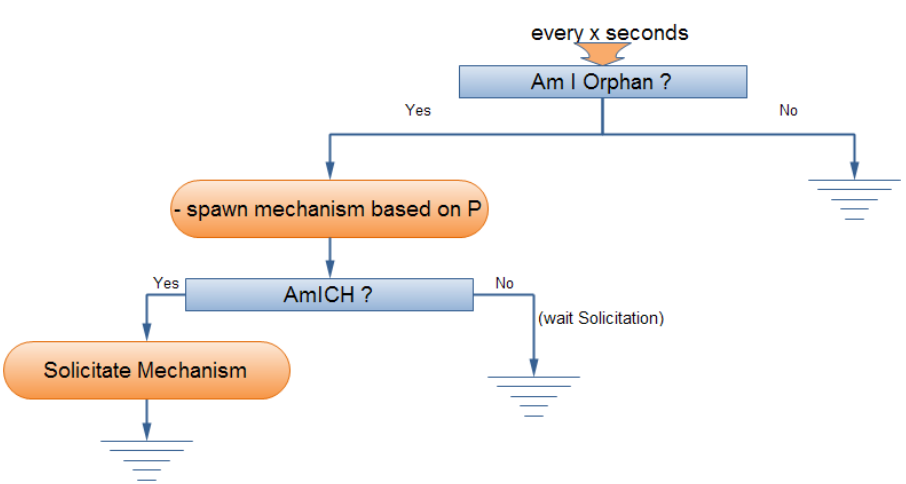
Figure 3. Periodic Mechanism for CH